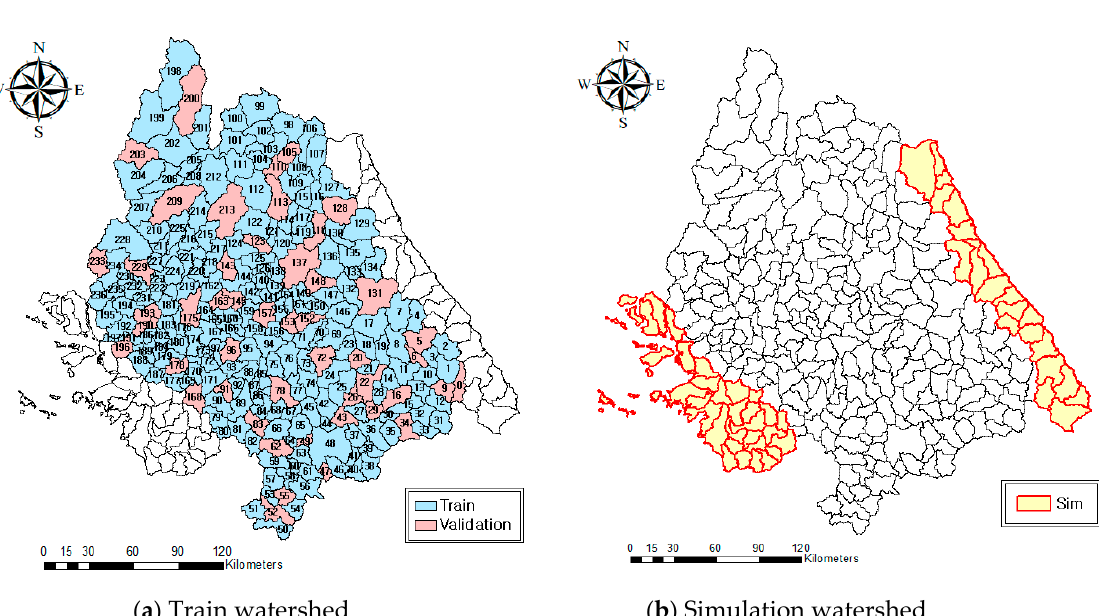
Figure 7. Training and Prediction Watersheds for Machine Learning.